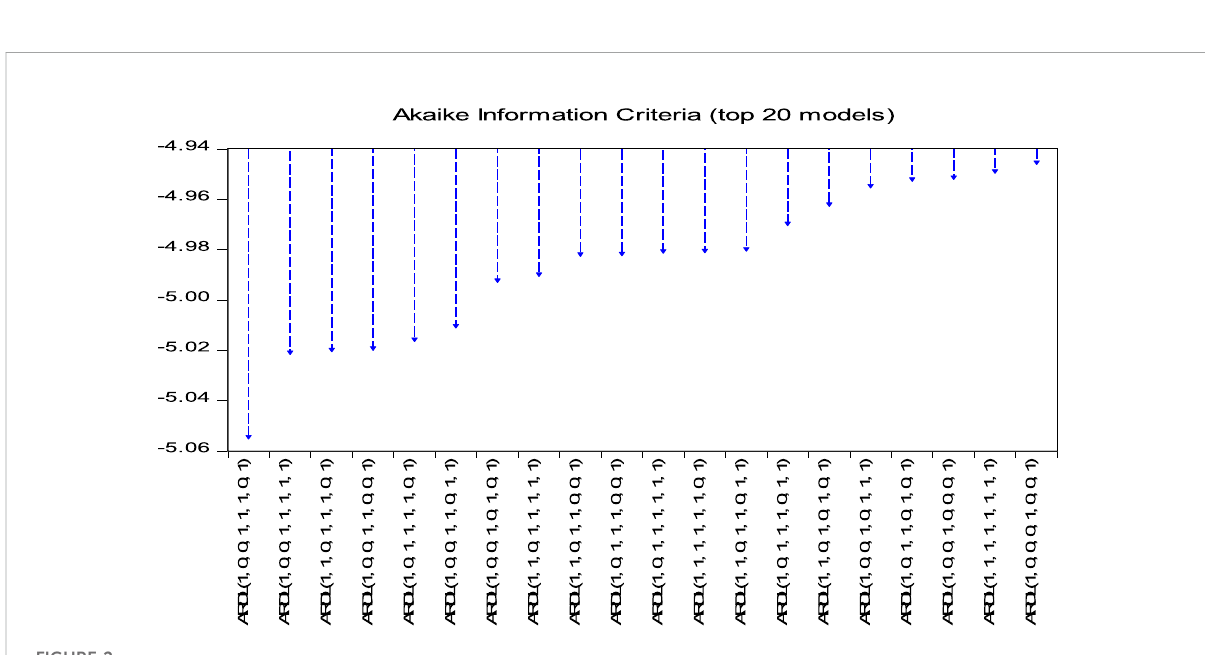
FIGURE 1 Periodic tendency of